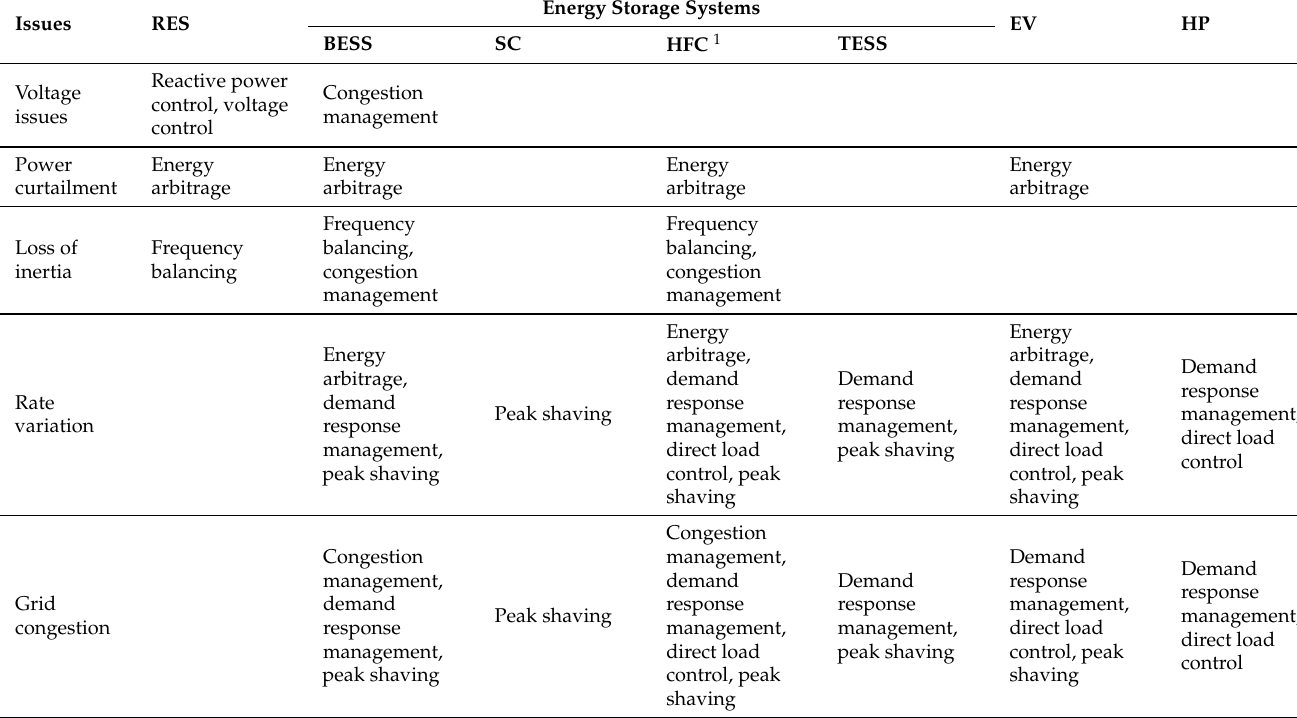
Table 6. Role of the elements in a multicarrier energy system when providing ancillary